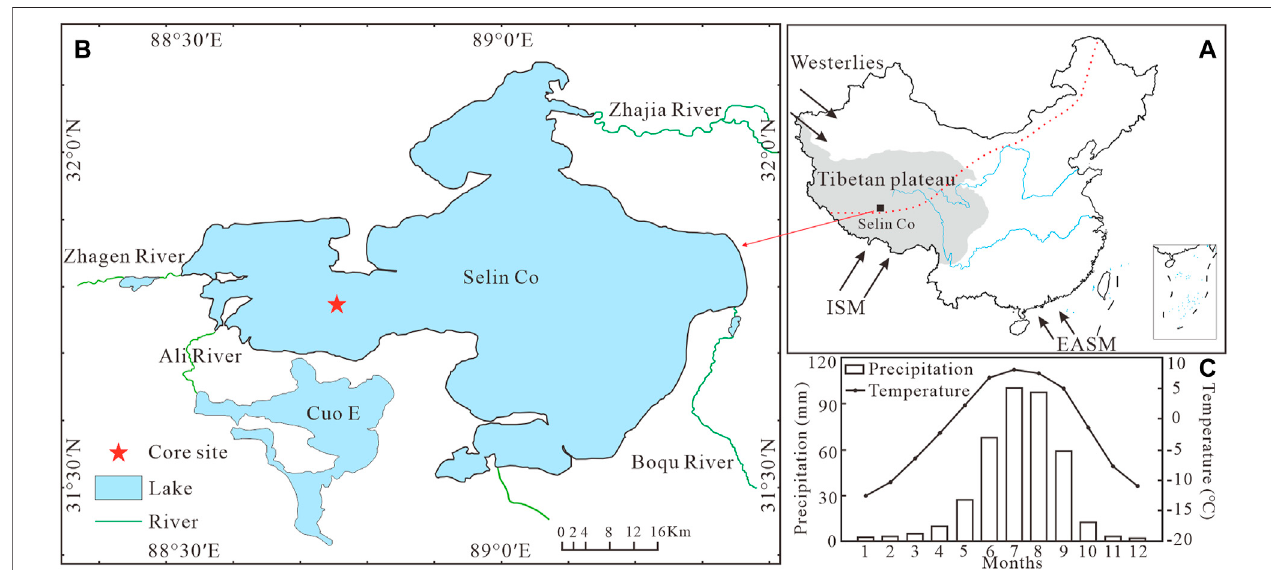
FIGURE 1| (A) Location of Lake Selin Co (black square) in the central Tibetan Plateau. (B) Core SL-4 site (red star) in Lake Selin Co (Yu et al., 2019). (C) Multi-year average monthly temperature and precipitation record (1979 – 2017; Wang et al., 2020). The modern East Asian monsoon limit is shown by the red dashed line (Gao 1962); ISM and EASM mean the Indian summer monsoon and East Asia summer monsoon, respectively.